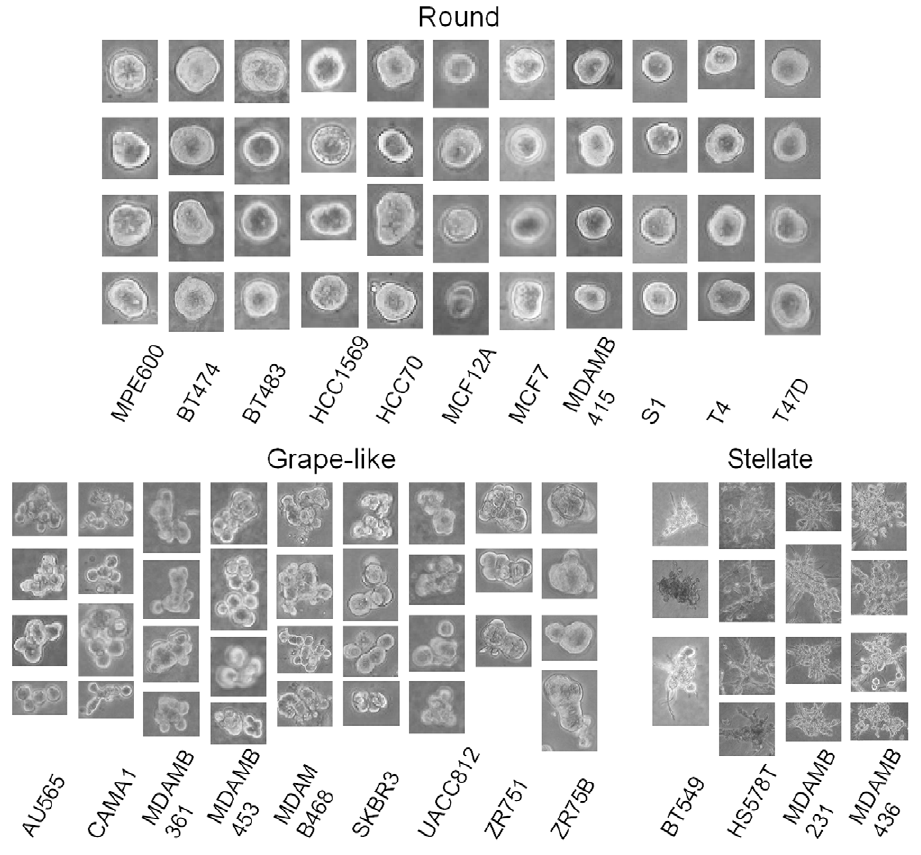
Figure 5. Three subpopulations of the 24 breast cancer cell lines grown in three-dimensional cell culture assay are revealed through consensus clustering.